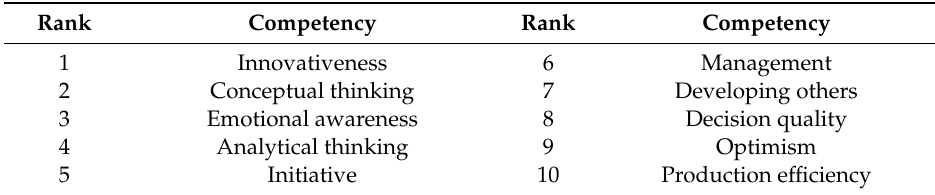
Table 6. The ten least significant competencies based on the project managers’ behavior in their current